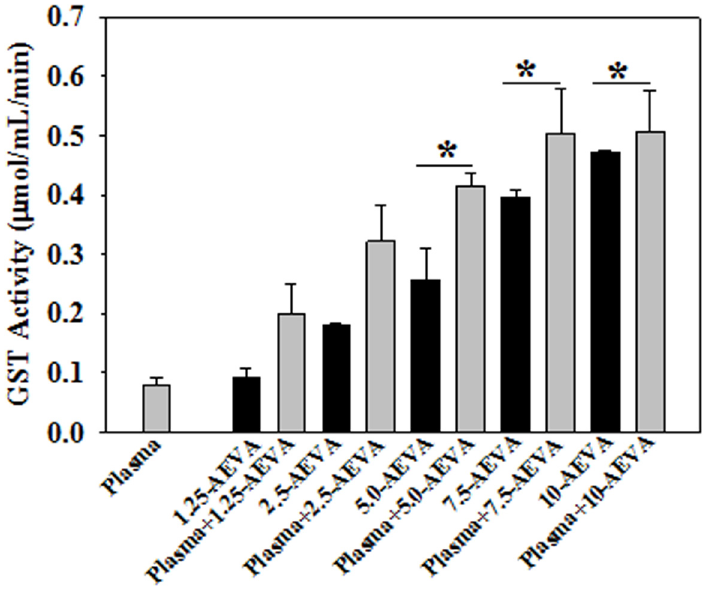
Fig 10. Effect of AEVA on GST activity in human plasma. 100 μ L of human plasma (collected from normal subject) was incubated with different concentration of AEVA (1.25, 2.50, 5.00, 7.50, and 10.00 μ g μ L -1 ) for 2 h at 37°C. “ * ” indicates the significant difference between “ AEVA alone ” and “ plasma + AEVA ” at the respective concentration of AEVA ( p < 0.05). Values are mean ± SE (n = 4).